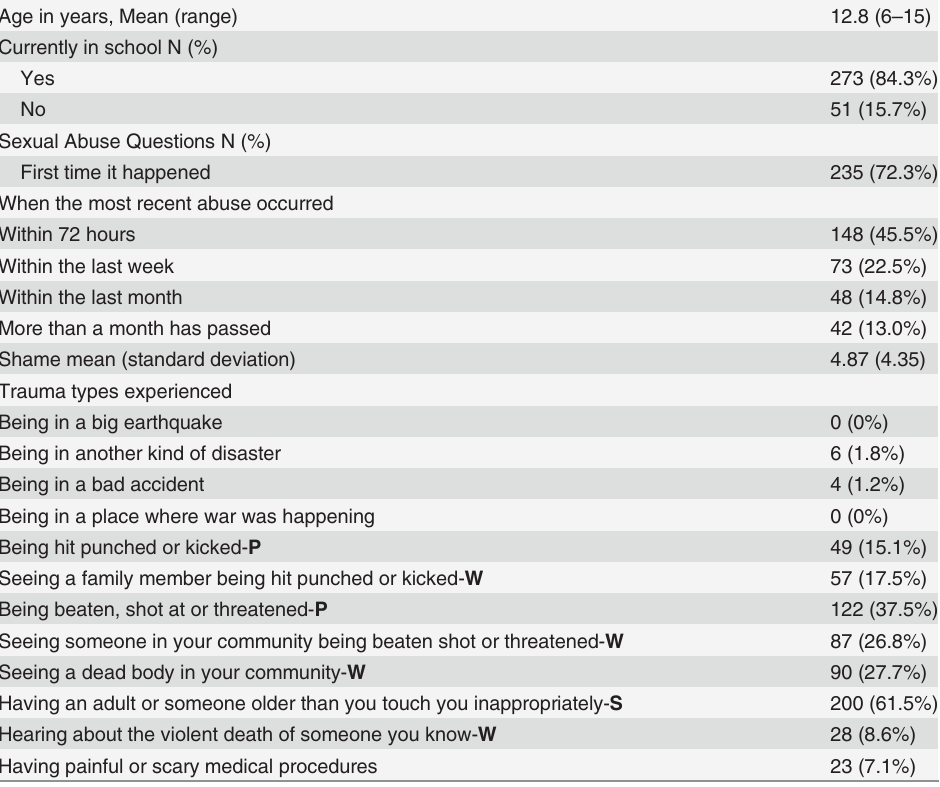
Table 1. Female Child Participant Demographics and Scale Scores (n =